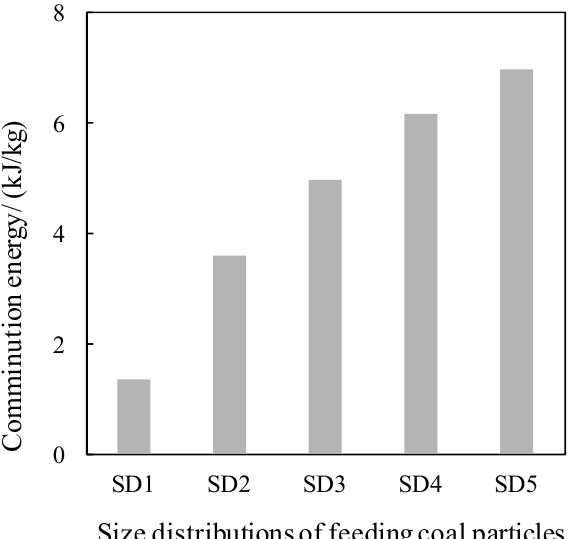
Figure 9. Change in comminution energy with coal particle size distribution.